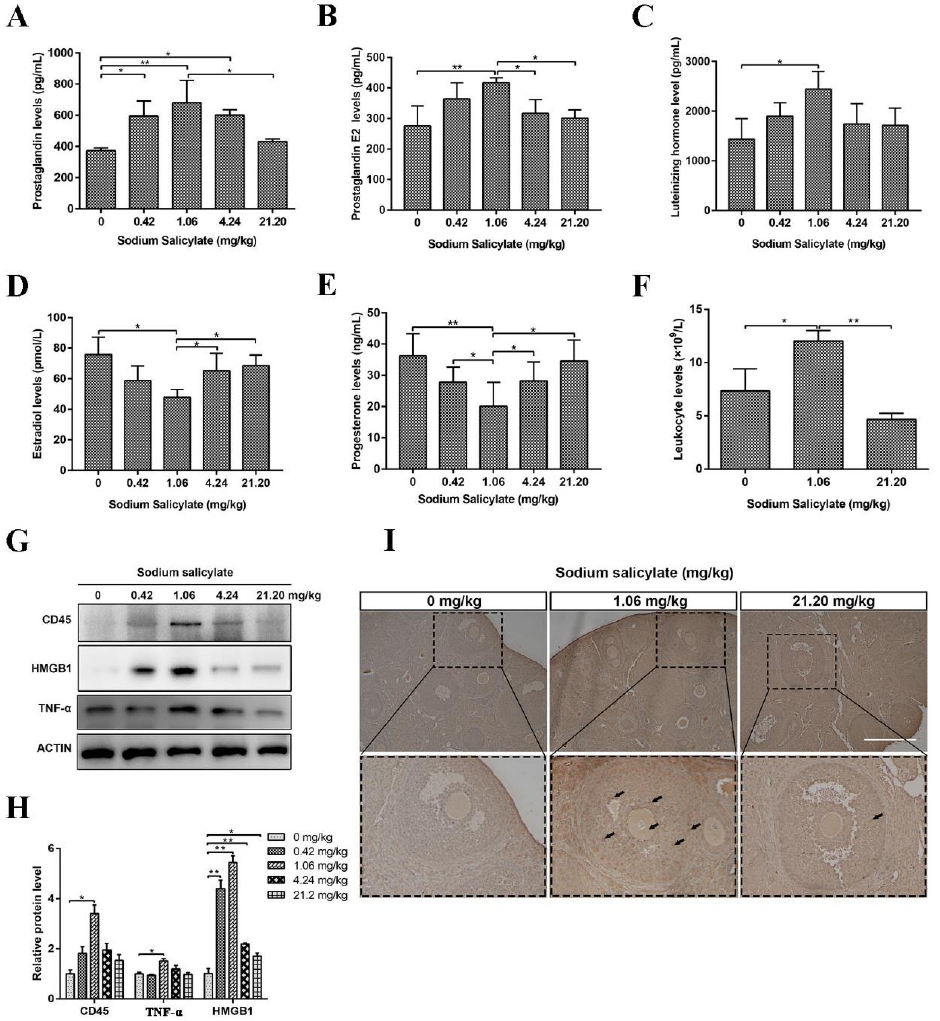
Figure 3. Effects of sodium salicylate on hormones and inflammation in mice. ( A – E ) Prostaglandin ( A ), PGE2 ( B ), luteinizing hormone ( C ), estradiol ( D ), and progesterone ( E ) levels in the blood of mice ( n = 3) treated with various concentrations of sodium salicylate. ( F , G ) Protein expression of HMGB1 and TNF- α in mouse ovaries in the different treatment groups. ( H ) Leukocyte levels in the 171 blood of mice treated with different concentrations of sodium salicylate ( n = 3). (I) CD45 (brown) 172 immunohistochemistry of ovarian tissue sections (arrows). * p < 0.05, ** p < 0.01. 173 2.4. Sodium Salicylate Activated P38 Signaling Pathway and the Key Protein CYP17A1 174 Studies have shown that the protein kinase A (PKA), protein kinase C (PKC), phos- 175 phatidylinositol 3-kinase (PI3K), tyrosine kinase, and the downstream mitogen-activated 176 protein kinase (MAPK) signaling pathways are involved in the development of oocytes in 177 the ovary. There were no changes in total p38 protein levels but a significant increase in 178 phosphorylated p38 (P-p38) ( p < 0.05; Figure 4A, B). c-Jun N-terminal kinase (JNK) is an 179